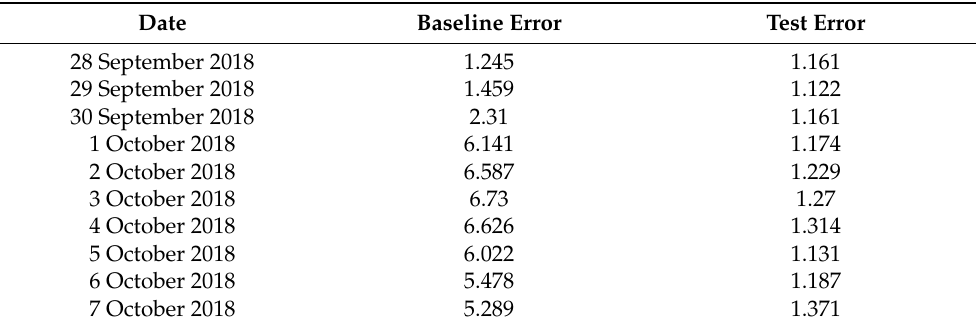
Table 2. Errors on the entire test set of the 10-parameter model by 1 h granularity on 27 September 2018 (Model 1).